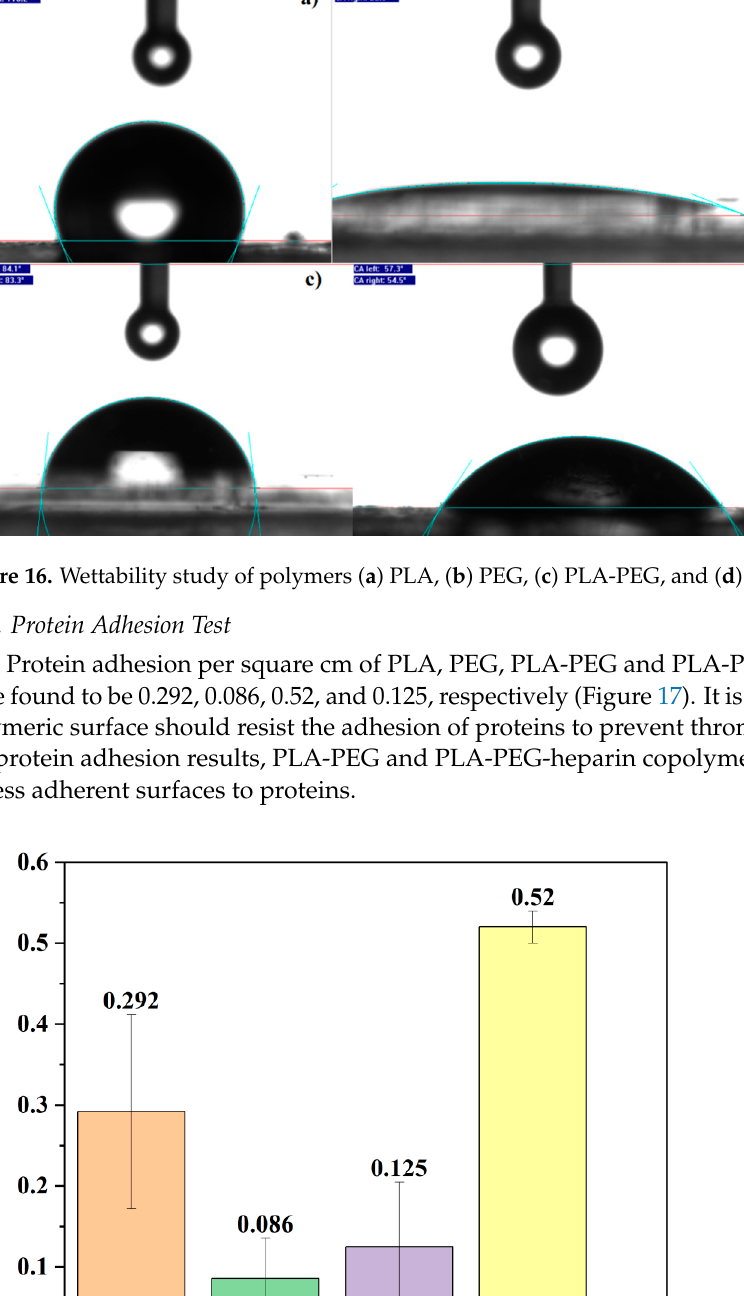
Figure 17. Protein adhesion test: (a) PLA, (b) PEG, (c) PLA-PEG, and (d) PLA-PEG-heparin.